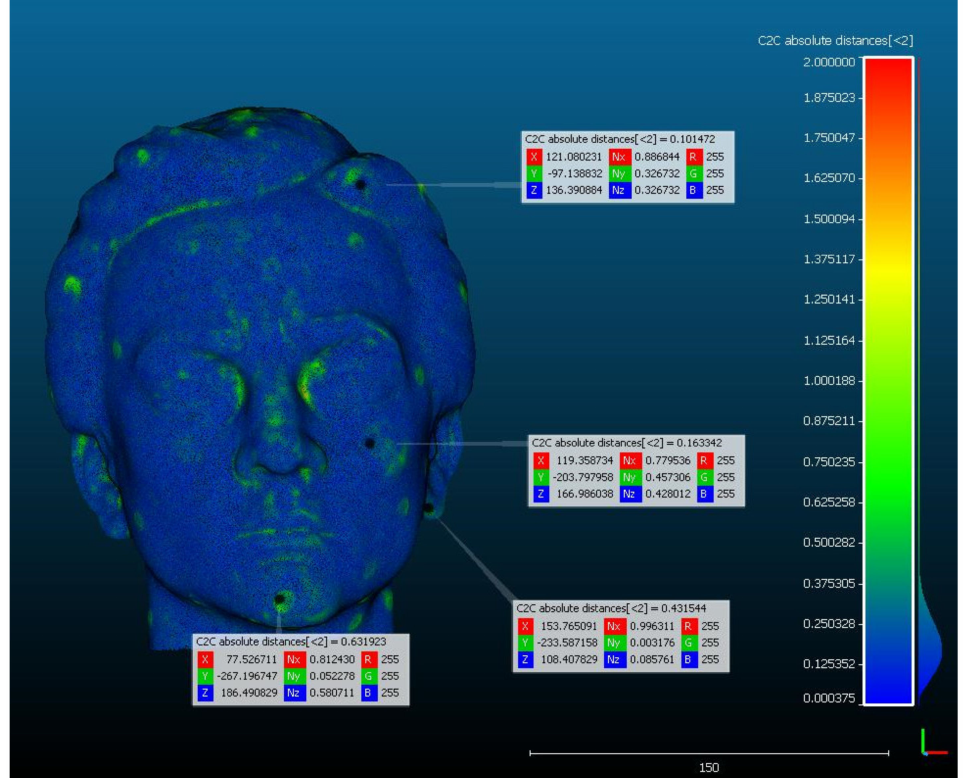
Figure 13. Results of the comparison of model with digital error obtained by scanning and by photogrammetry in CloudCompare